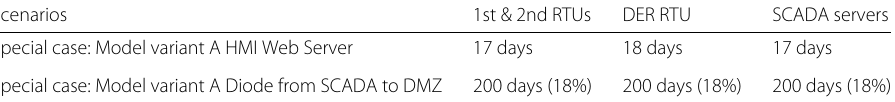
Special case: Model variant A HMI Web